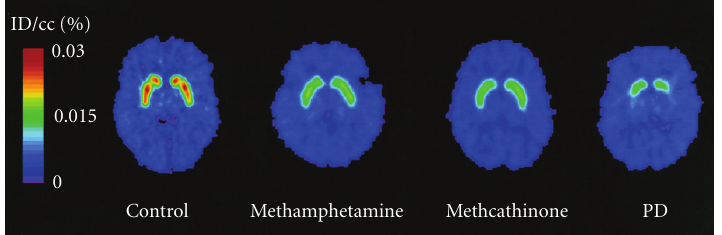
Figure 5: Reduced DAT function in methamphetamine users. PET images showing accumulation of (11C) WIN-35 428 in the striatum in a control subject, an abstinent methamphetamine subject, an abstinent methcathinone subject, and a PD patient 70–90 min after injection of (11C) WIN-35 428. Taken from McCann et al.